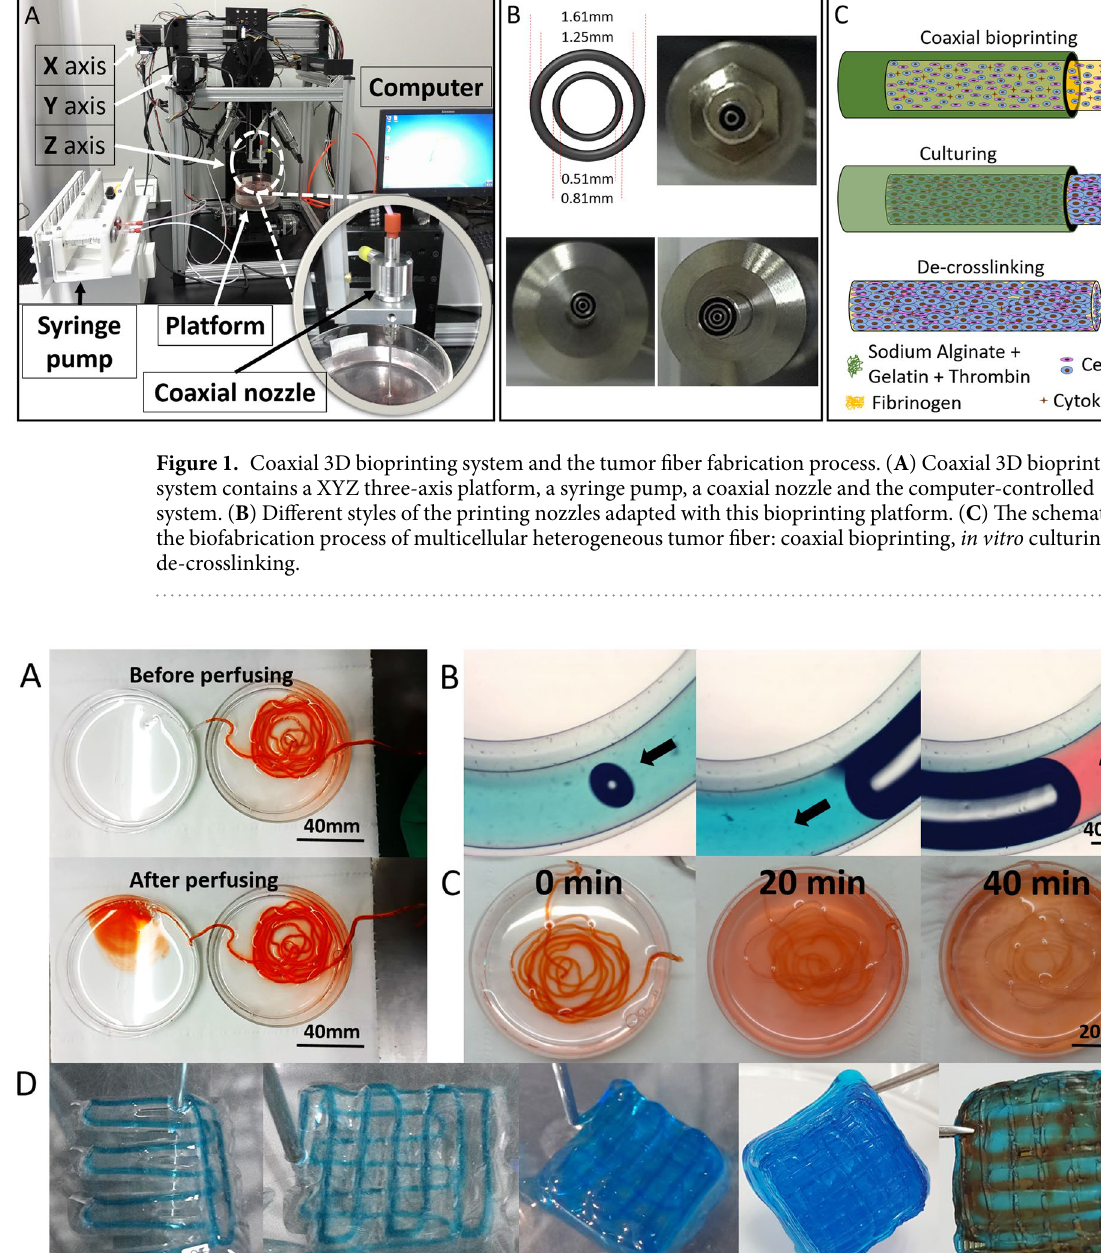
(Fig. 3D). It is very important to have proper extrusion parameters for the core suspension: when the extrusion rates of cell suspension and A/G were 3 ml/h and 30 ml/h, respectively, the inner and outer diameters of the A/G shell were (242.89 ± 14.76) μ m and (870.87 ± 17.96) μ m, respectively (Fig. 3E); when the extrusion rate of cell suspension increased to 10 ml/h, the inner and outer diameters of the shell were (527.49 ± 13.36) μ m and (886.71 ± 9.83) μ m, respectively (Fig. 3F). Thus, by adjusting the extrusion speed, inner diameter of the shell, or the diameter of core cell fiber, could be changed while the outer diameter remained unchanged. This phenome- non was in exact agreement with what has been reported previously 24 .